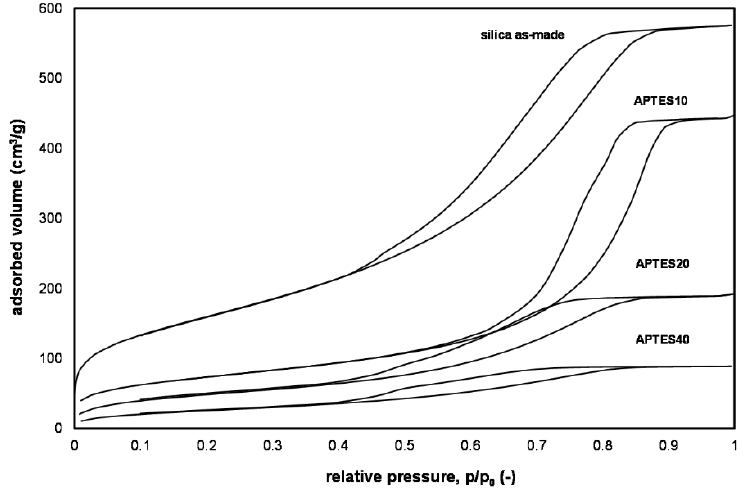
Figure 2. N 2 adsorption-desorption isotherms at 77 K for the as-made and APTES-grafted silicas: Data of as-made silica, APTES20, and APTES40 from reference [35]. Table 1. Particle density, Brunauer–Emmett–Teller (BET) specific surface, and Barrett–Joyner– Halenda (BJH) pore volume of the adsorbent